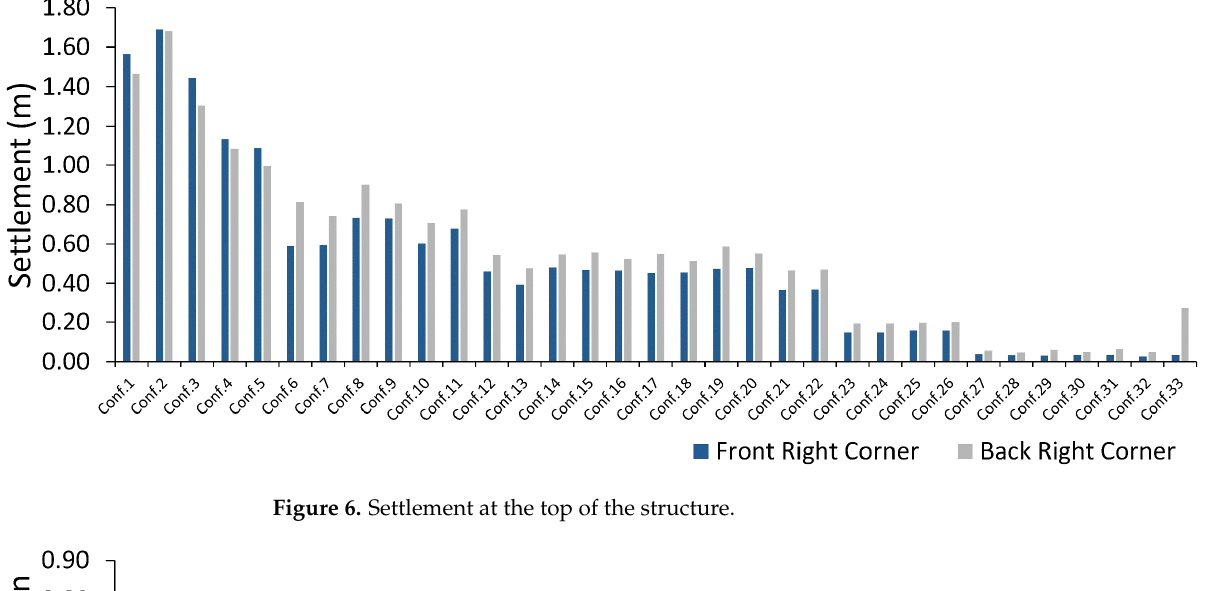
Figure 6. Settlement at the top of the structure.